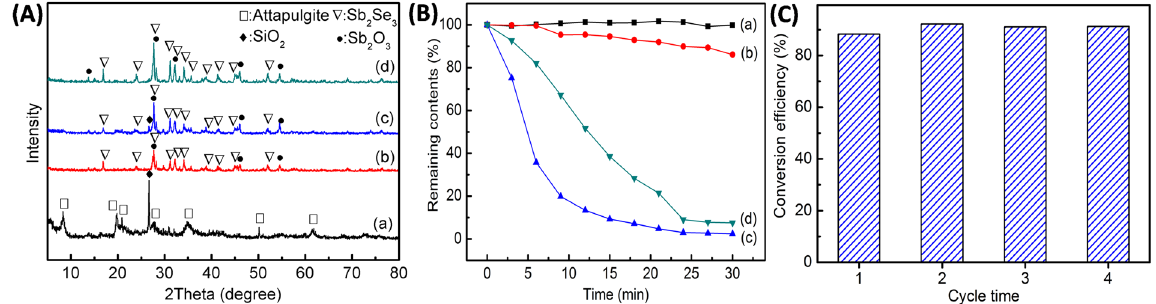
Figure 2. ( A ) XRD patterns of (a) pure attapulgite, (b) Sb 2 Se 3 sample, (c) Sb 2 Se 3 -Sb 2 O 3 -attapulgite and (d) Sb 2 Se 3 /Sb 2 O 3 @attapulgite; ( B ) Plots for the catalytic reduction of p-NP by (a) pure attapulgite, (b) Sb 2 Se 3 -Sb 2 O 3 - attapulgite, (c) Sb 2 Se 3 /Sb 2 O 3 @attapulgite and (d) Sb 2 Se 3 sample and ( C ) the recyclability of the as-prepared Sb 2 Se 3 /Sb 2 O 3 @attapulgite for catalytic hydrogenation of